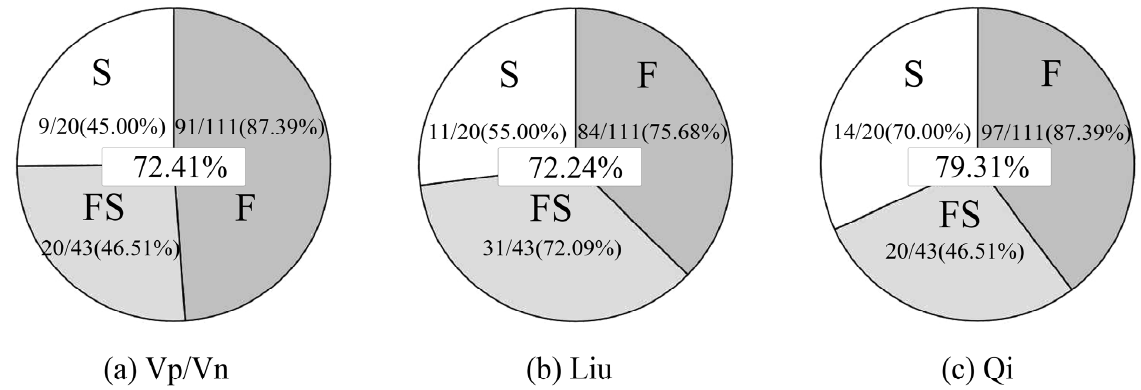
Figure 5. Discriminant results based on shear force.